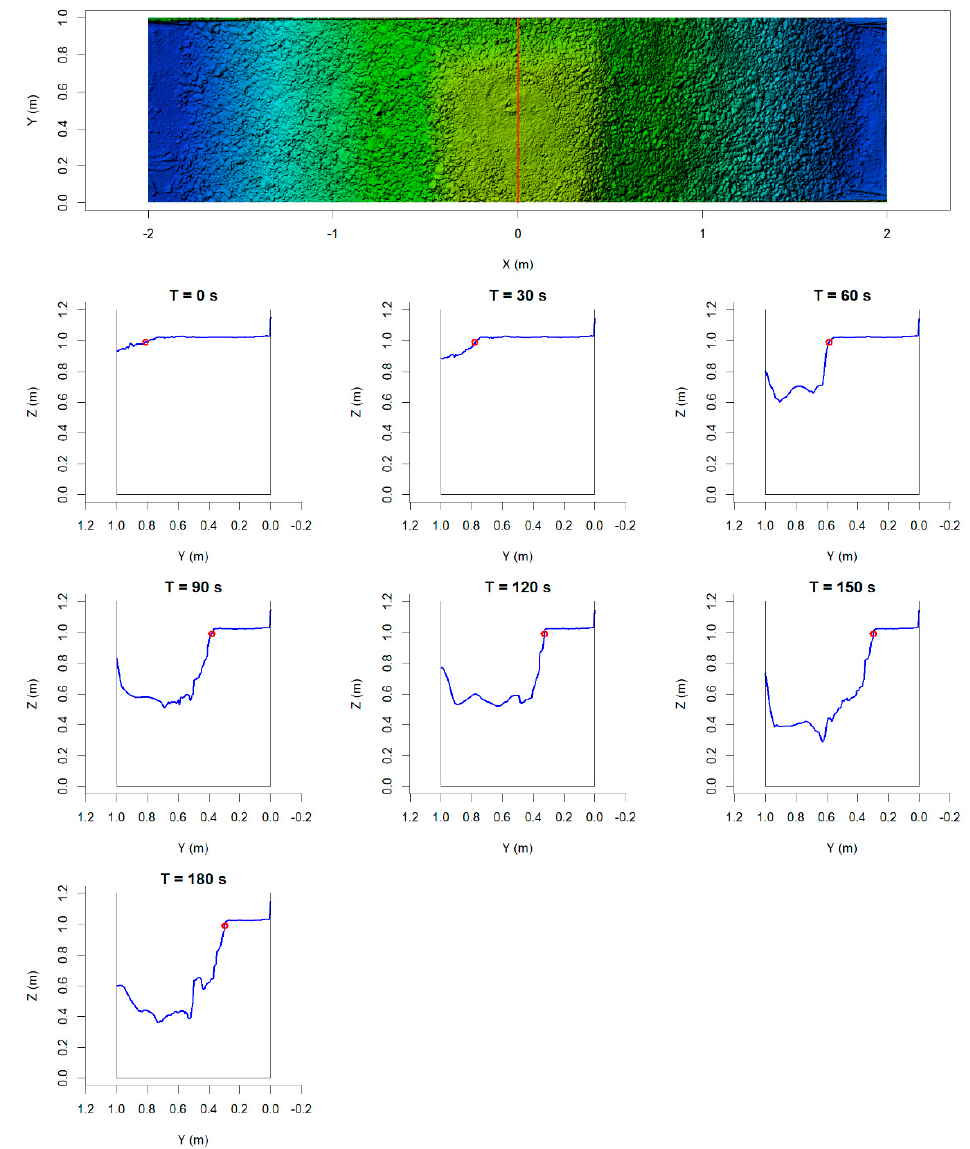
Figure A6. Cross-section profiles for X = 0 m (centre line) extracted from H1 dynamic 3D model; T = 0 s is immediately before initial observed erosion at downstream edge of crest; red circle indicates breach edge as used in further analyses.